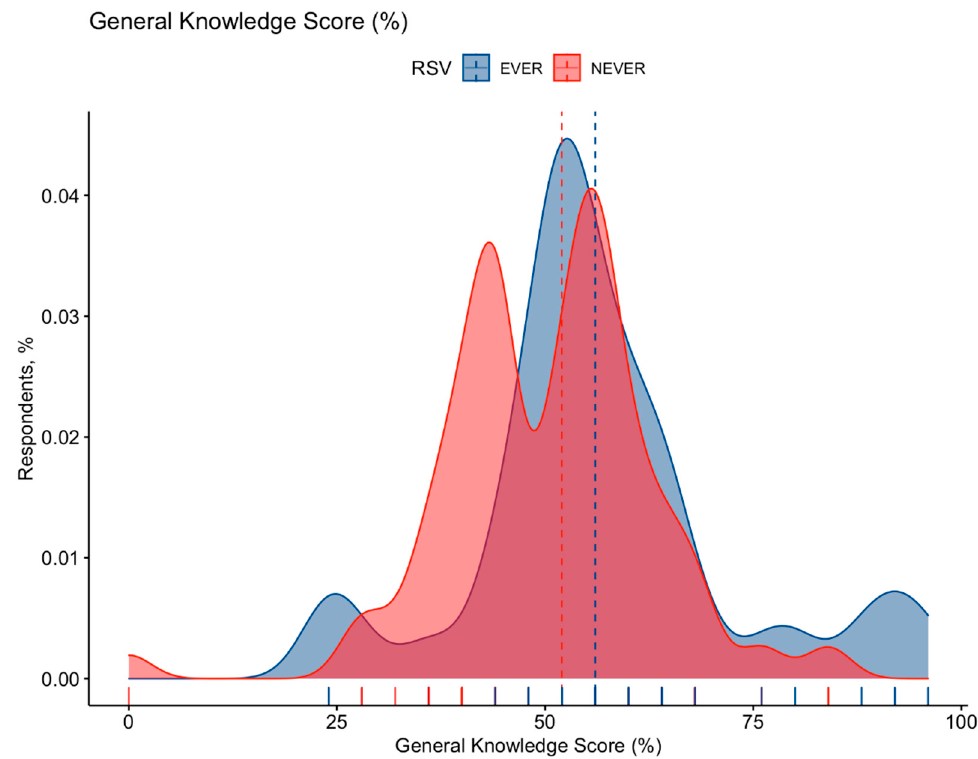
Figure 2. Density plot for General Knowledge Score (GKS) in 389 Italian Pediatricians participating into the survey, broken down by having or not having cared for Respiratory Syncytial Virus (RSV) cases in the previous 5 years. Cumulative score was substantially skewed for GKS (D’Agostino–Pearson’s normality test: p = 0.084). GKS was substantially greater among participants that had previously cared for RSV cases (56.6% ± 15.5) than among those having not (50.4% ± 12.6, Mann–Whitney test p value < 0.001).